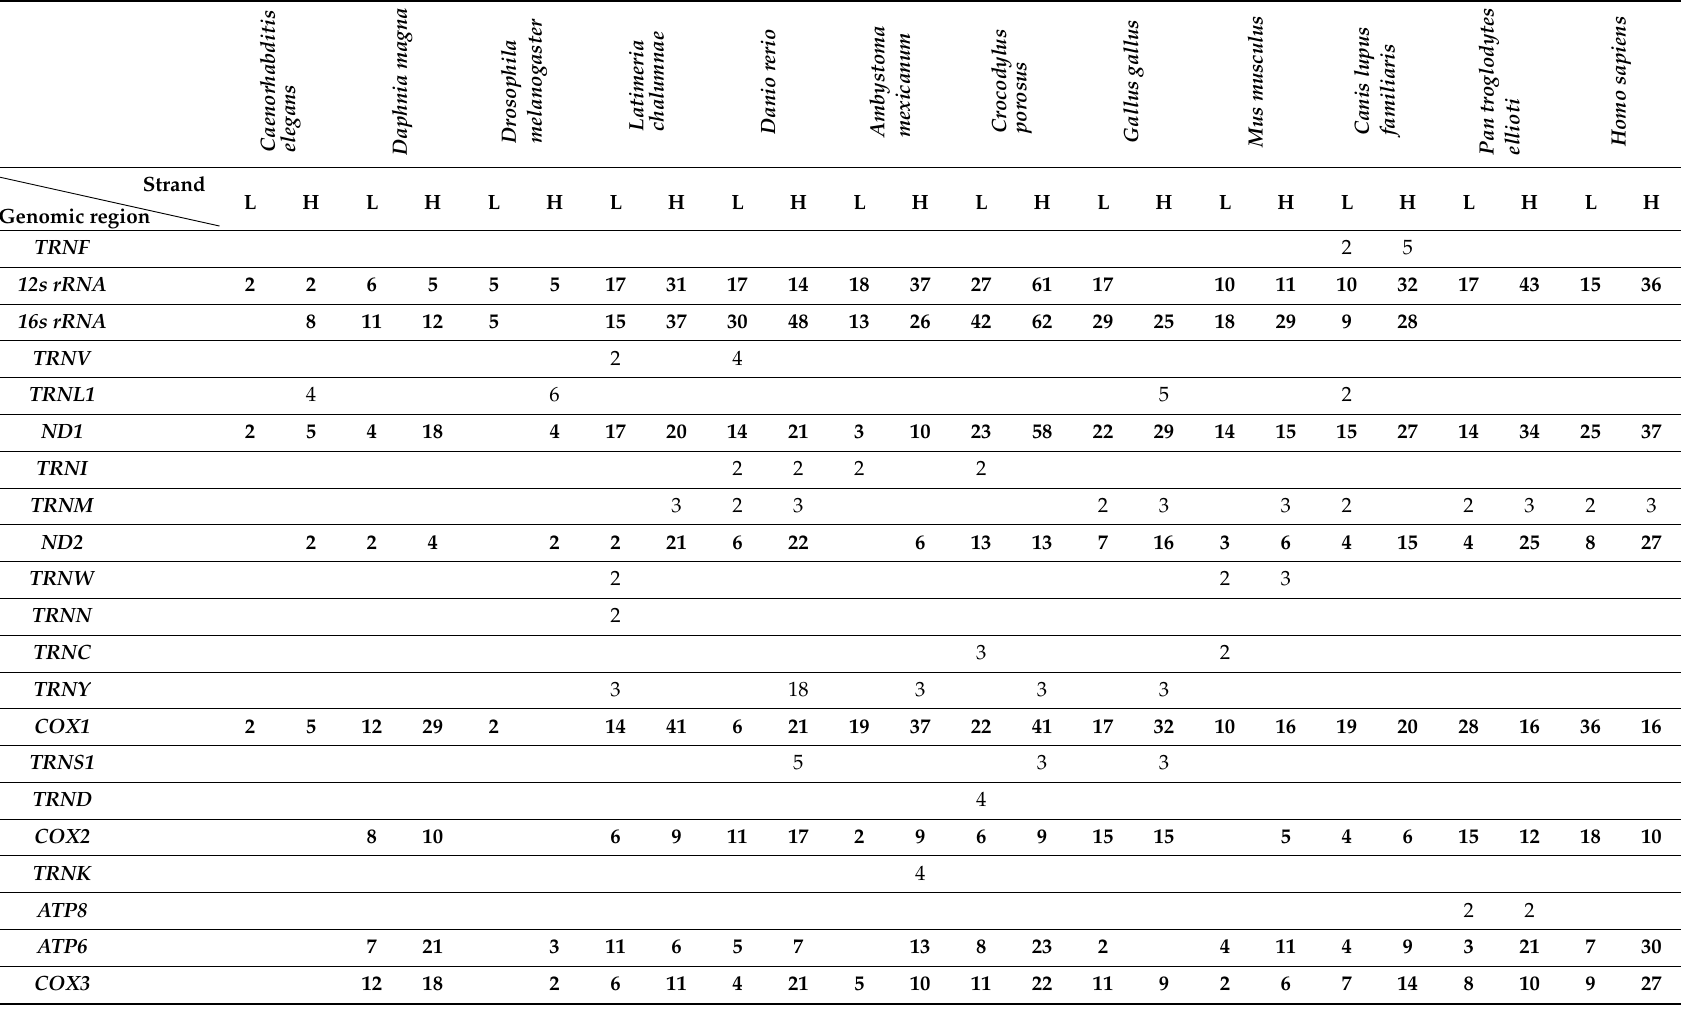
Table 4. Distribution of CpG sites in the mtDNA of the analysed animals including the L- strand and the H-